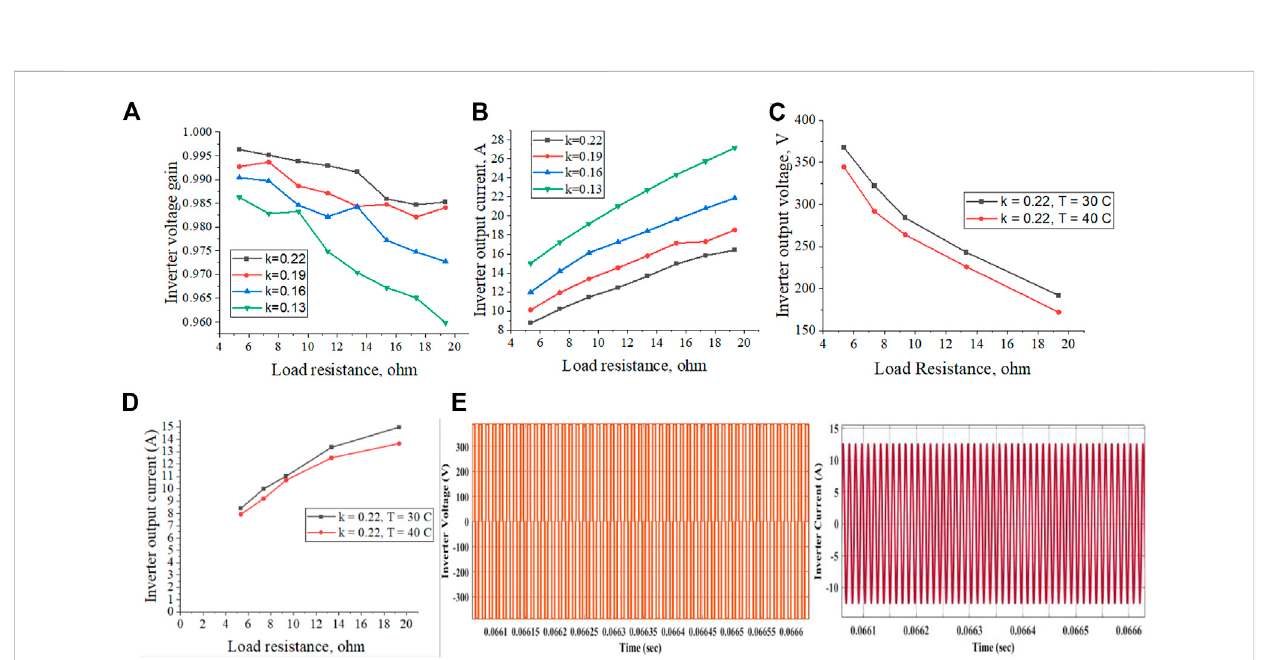
FIGURE 7 Response of HPHFI (A) Load resistance Vs. Voltage gain (B) Load resistance Vs. Leg to Leg inverter current (C) Load resistance Vs. Output voltage (with different temperature) (V) (D) Load resistance Vs. Inverter output current (with different temperature) (E) Current and a voltage waveform of the